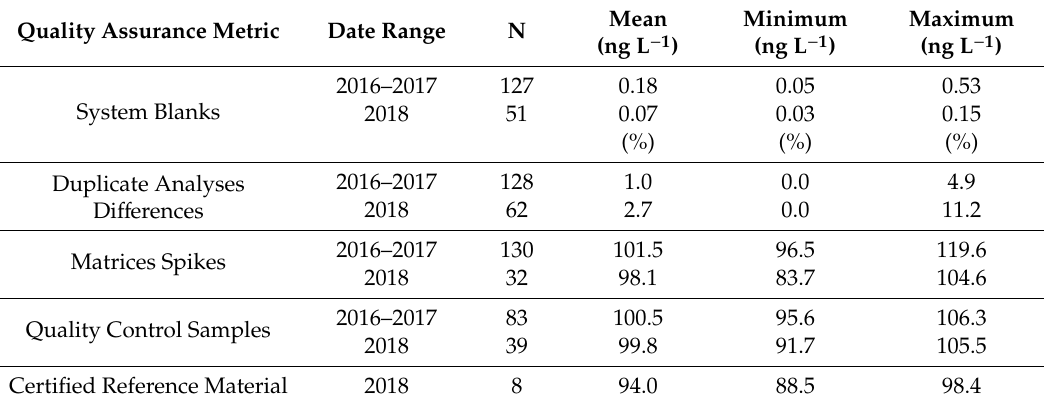
Table 2. Asia Pacific Mercury Monitoring Network quality assurance results from two periods, 2016–2017 and 2018. A new analysis instrument was added at the end of